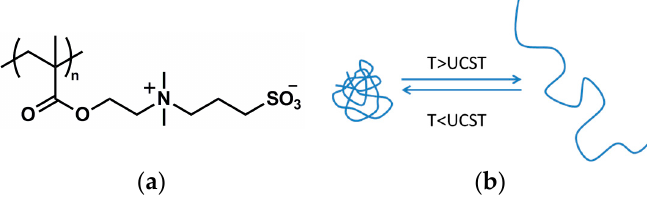
Figure 5. ( a ) Structure of poly(38) and ( b ) schematic illustration of upper critical solution temperature (UCST) of a polymer in solution.